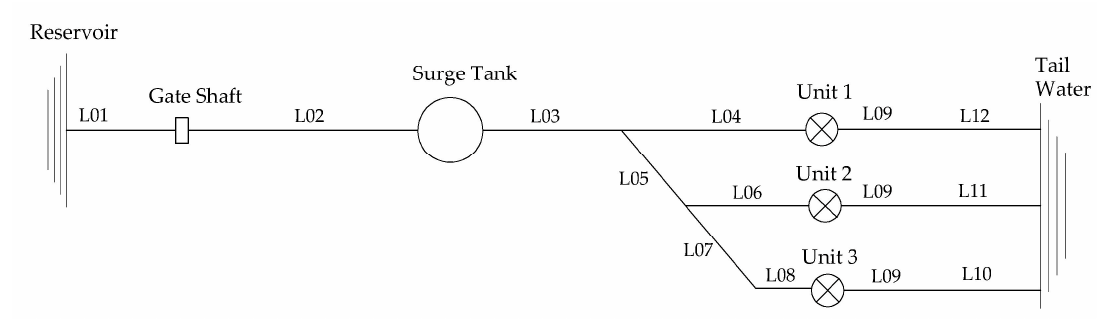
Figure 1. Layout of the hydropower system.